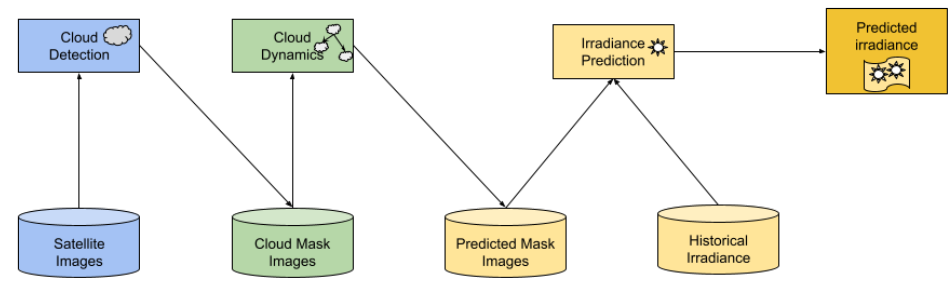
Figure 3. Full workflow for a prediction.